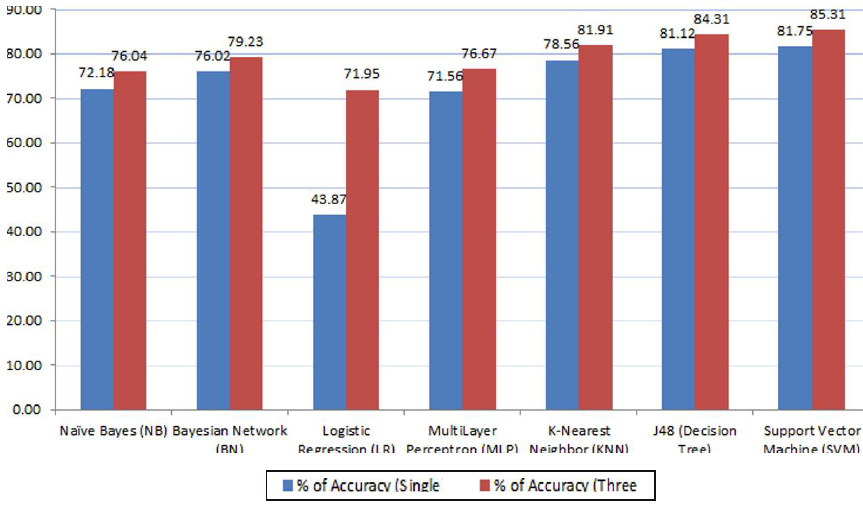
FIG. 6. RECOGNITION ACCURACY COMPARISON, 1 VS. 3 GROUPS OF ACTIVITIES